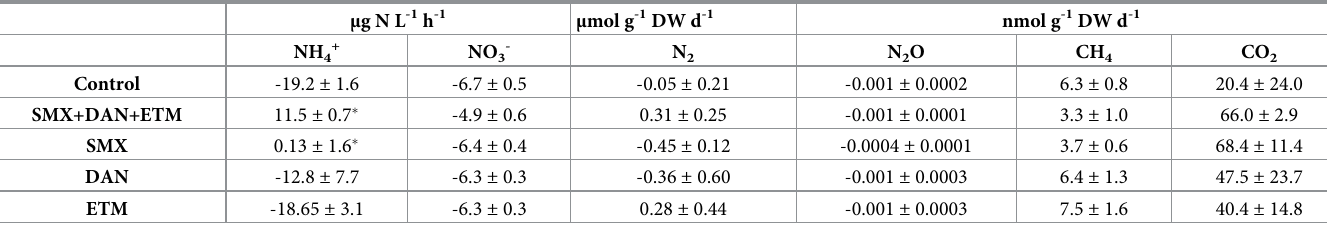
Table 4. Mean ± SE consumption and production rates of nitrogen species (NH4+, NO3-, N 2 , N 2 O), CH 4 , and CO 2